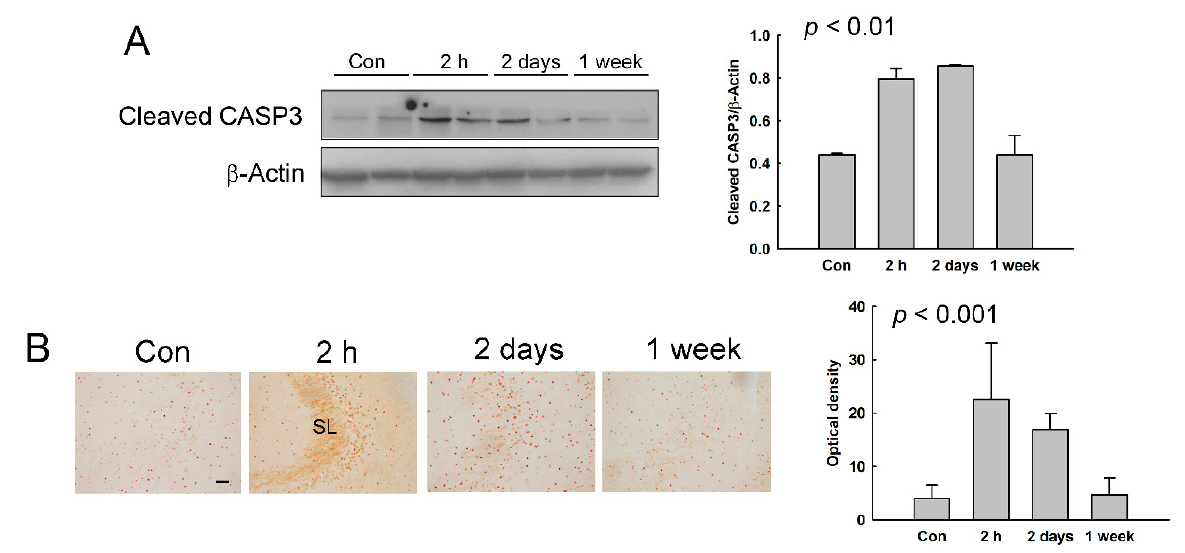
Figure 6. The expressions of cleaved caspase 3 (CASP3) in the hippocampus of NMDA-treated rats. ( A ) The expressions of cleaved CASP3 in the hippocampus were assessed using western blotting. The histograms represent the protein expression levels divided by the expression level of β -actin as the mean ± SD. β -Actin was used as an internal control. ( B ) Cleaved CASP3-immunoreactivity (IR) was examined in the hippocampus. The optical density of cleaved CASP3-IR is shown as the mean ± SD. Scale bars = 50 μ m. SL, stratum lucidum.